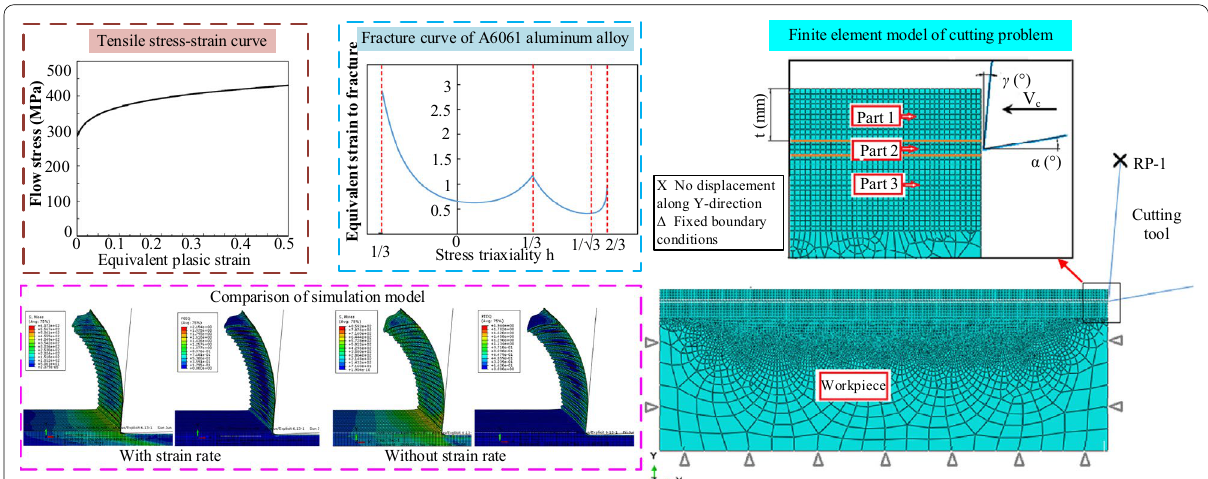
Figure 6 Finite element simulation of high speed milling of aluminum alloy A6061